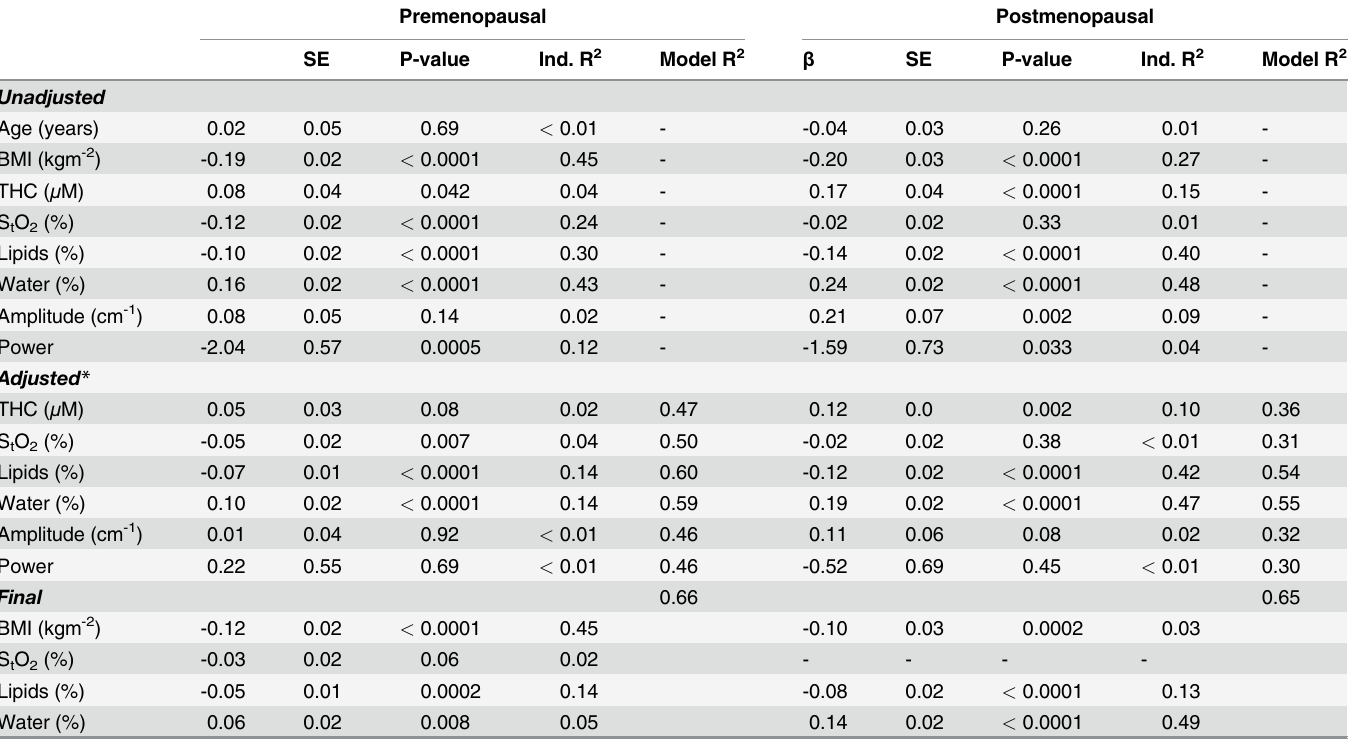
Table 4. Unadjusted, adjusted (for age and BMI) and fi nal regression coef fi cients ( β ) and standard errors (SEs) for breast tissue optical properties with percent density (square root transformation) for 95 pre- and 107 post-menopausal